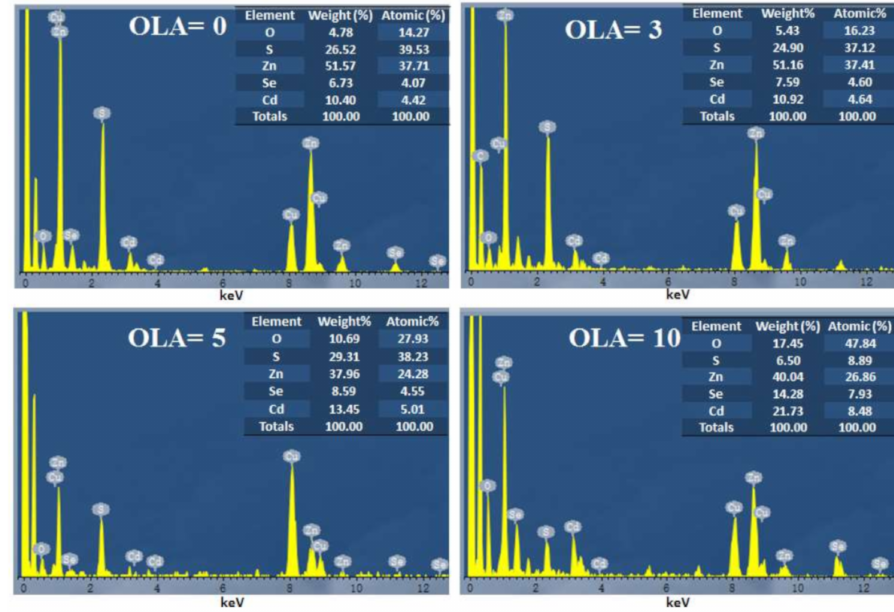
Figure 3. EDS spectra of as-obtained QDs obtained at different OLA.